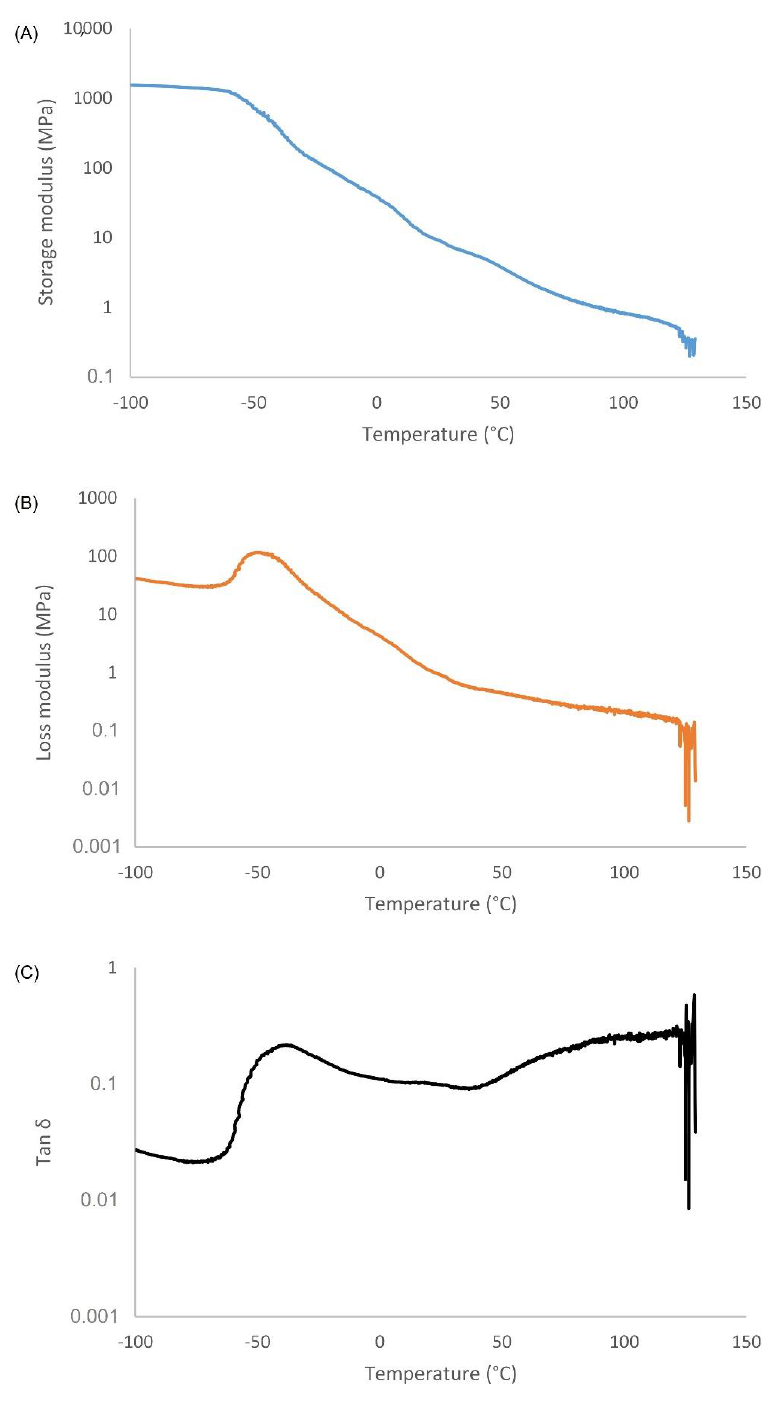
Figure 8. Dynamic mechanical properties of PU networks in DMA measurements: ( A ) storage modulus (E′) versus temperature; ( B ) loss modulus (E’’) versus temperature and ( C ) tan δ versus tem- perature.